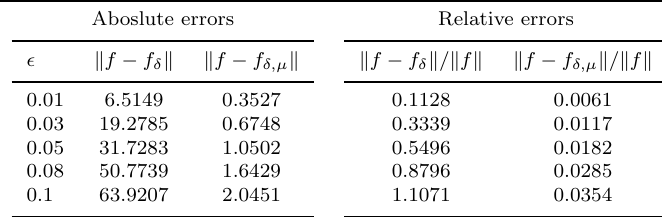
Figure 4. Sources for Example 4: original (a), unregularized (b) and regularized (c) assuming α 2 = 1 , β = (0 , 0) ,ν = 1 ,t 0 = 0 . 4 ,p = 0 . 6 and (cid:15) = 0 . 05. Table 4. Example 4: Errors assuming α 2 = 1 , β = (0 , 0) ,ν = 1 ,t 0 = 1 ,p =